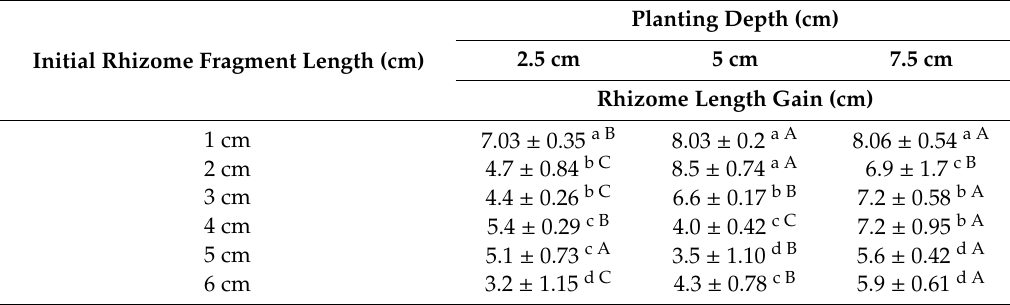
Initial Rhizome Fragment Length